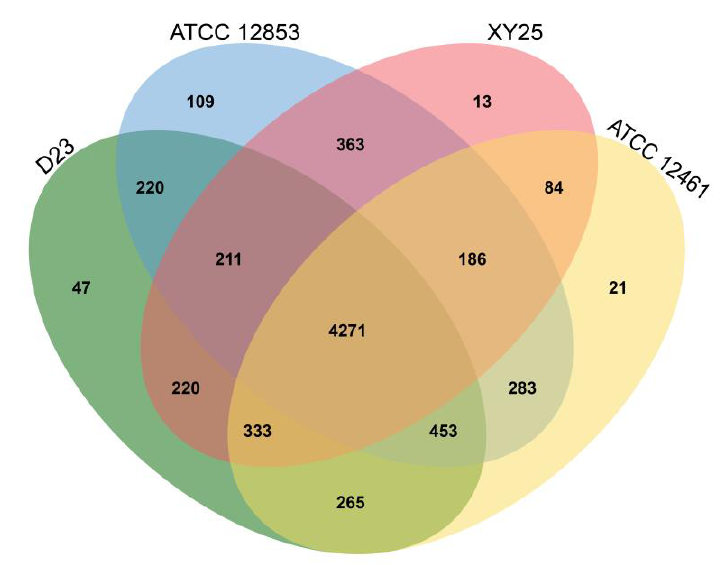
Figure 5. Venn diagram of comparative homologous protein analysis of the S. huasconensis D23, S. alfalfae XY25, S. alboniger ATCC12461, and S. kanamyceticus ATCC12853 genomes.